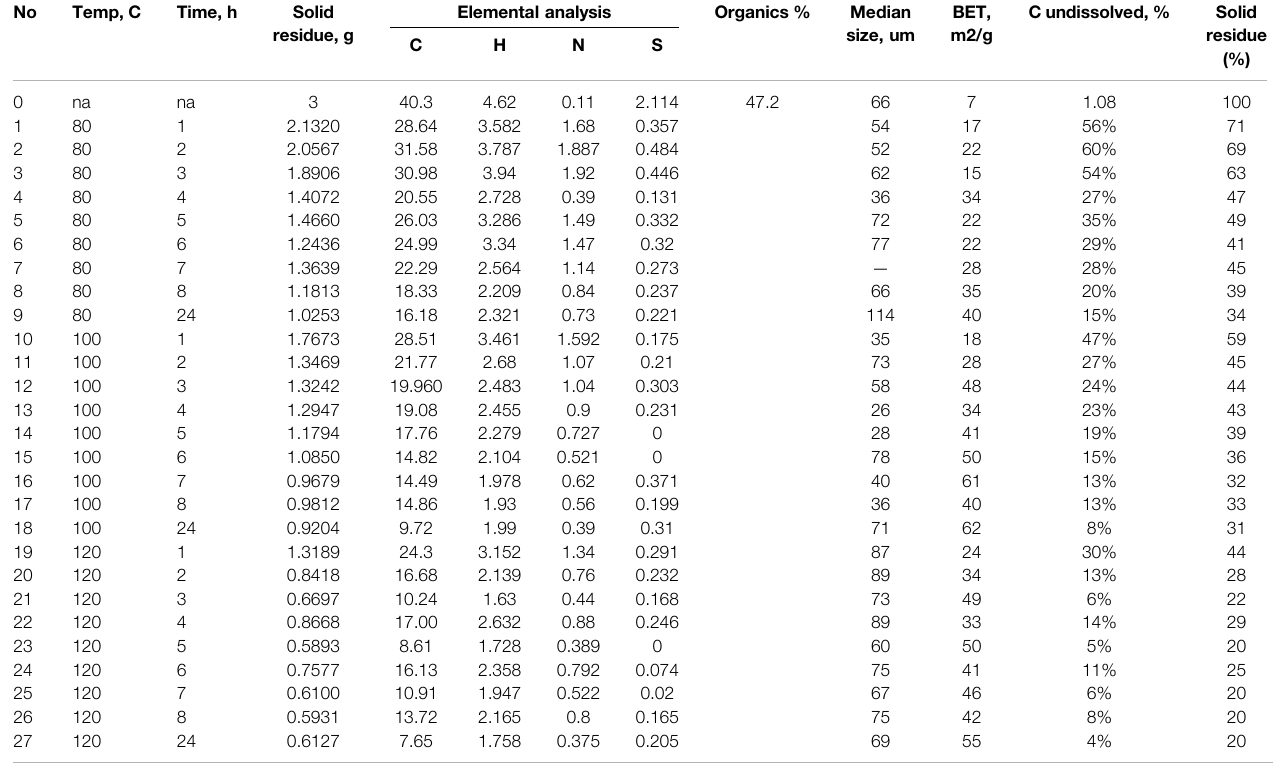
TABLE 1 | Aggregate data on elemental analysis, speci fi c surface area, and solid reaction residue. No Temp, C Time, h Solid Elemental residue, g